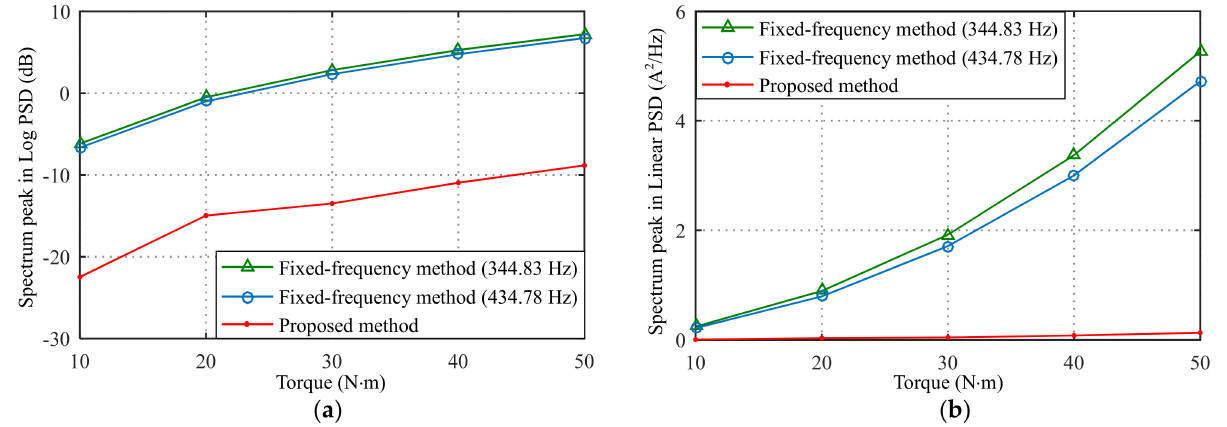
Figure 14. Comparison between the proposed method and the fixed-frequency method in terms of injection-induced maximum current spectrum peak in: ( a ) log PSD; ( b ) linear